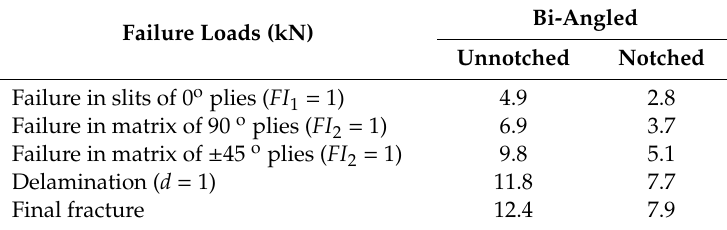
Figure 14. Typical DIC strain field near the open hole of the notched specimen: ( a ) specimen surface with random speckle pattern, ( b ) typical strain field in the load direction of the present notched UACS laminate at 90% of the final failure load (7.1 kN). Table 3. Failure loads for di ff erent stages of the damage